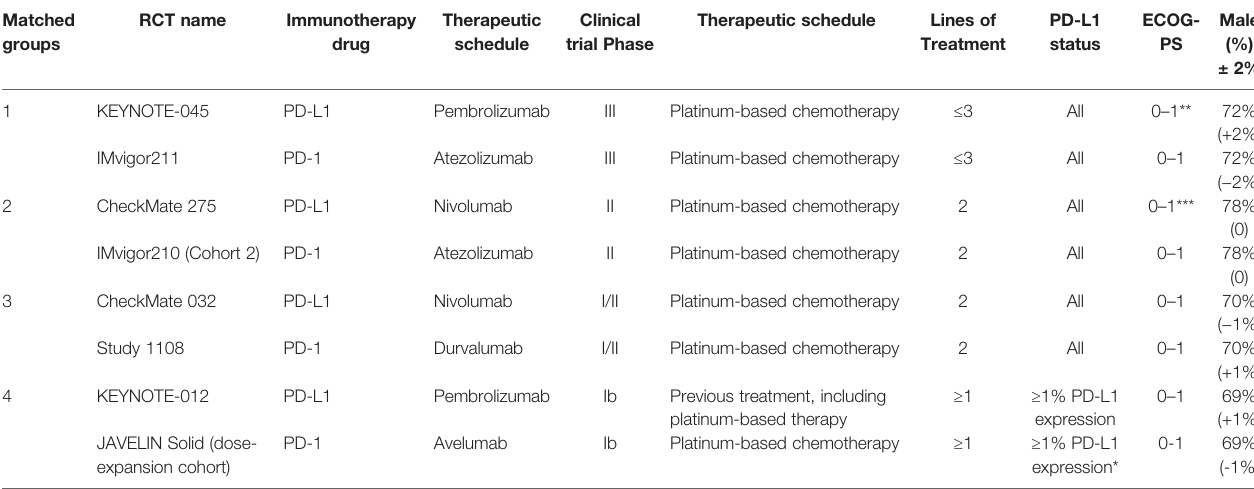
TABLE 2 | The indirect comparison of selected studies based on the mirror principle.